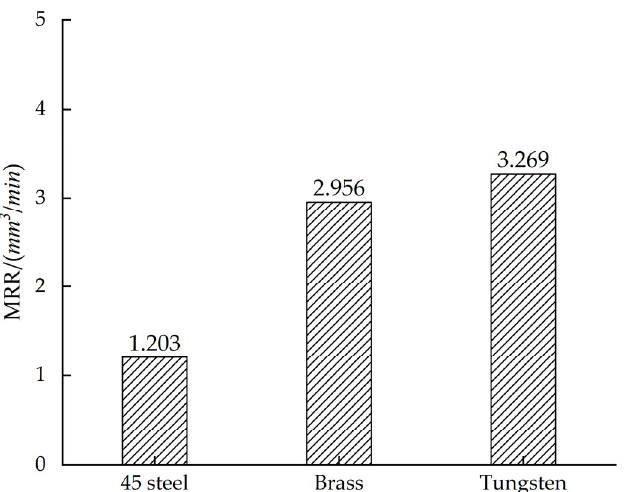
Figure 5. Comparison of feed rate and MRR for different electrode materials.